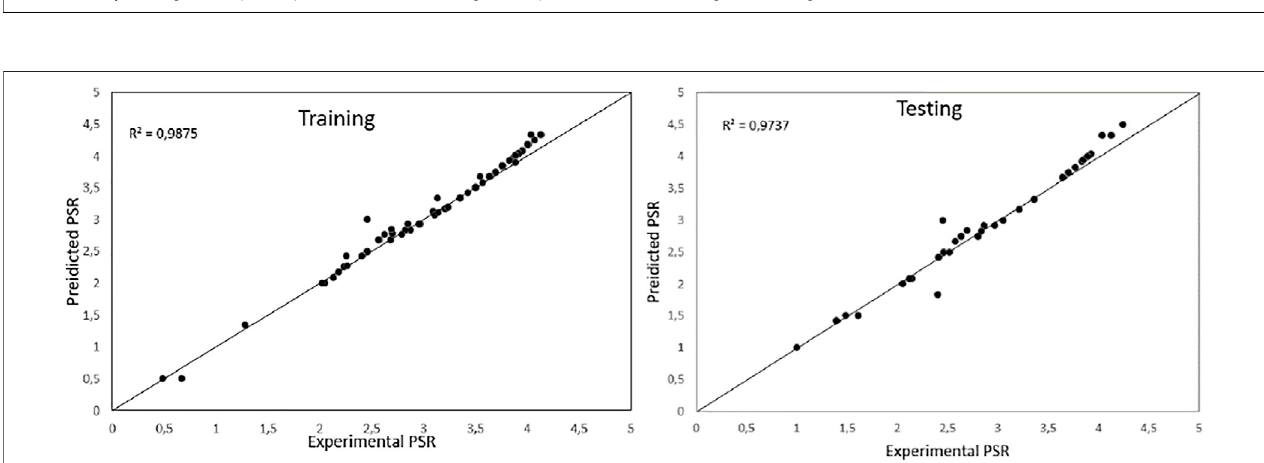
FIGURE 13 | The regression plot of predicted model 3 PSR against experimental PSR for testing and training data.